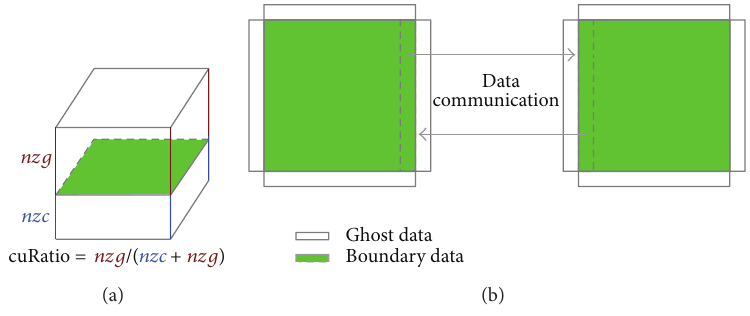
Figure 3: (a) Intraprocess partition. (b) The data exchange communications. Table 1: The performances before and after optimization.